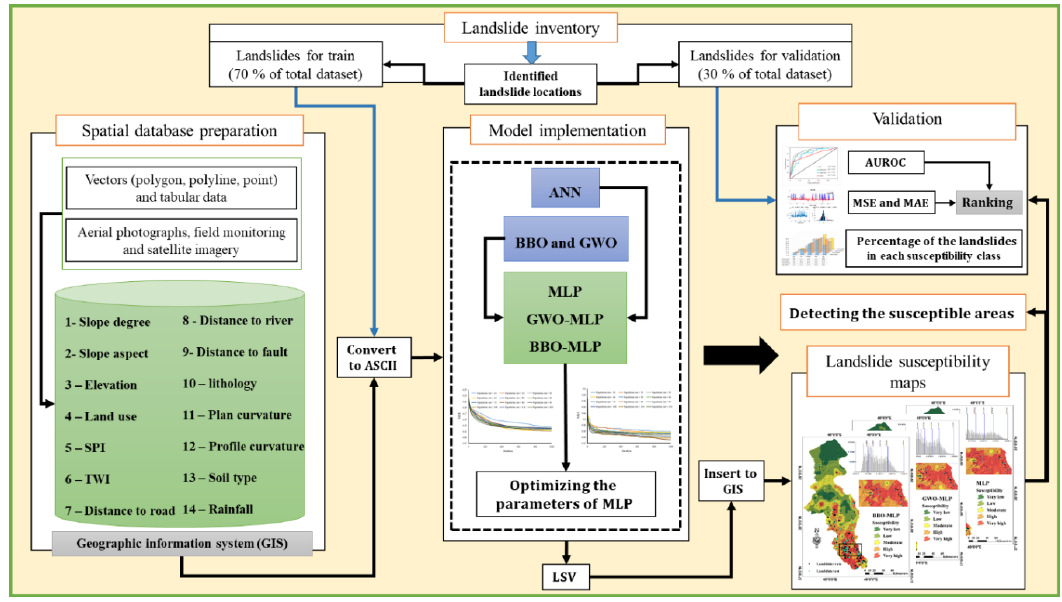
Figure 5. Graphical description of the applied procedure in this study.